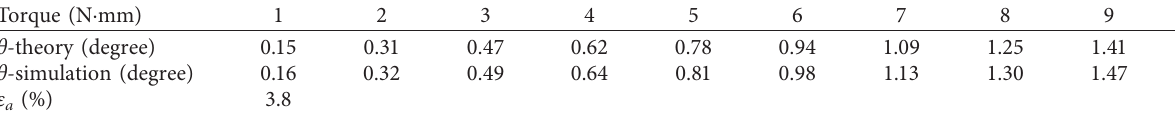
Table 6: Comparison of bending angle of TLET around y -axis: theory, simulation, and experiment.